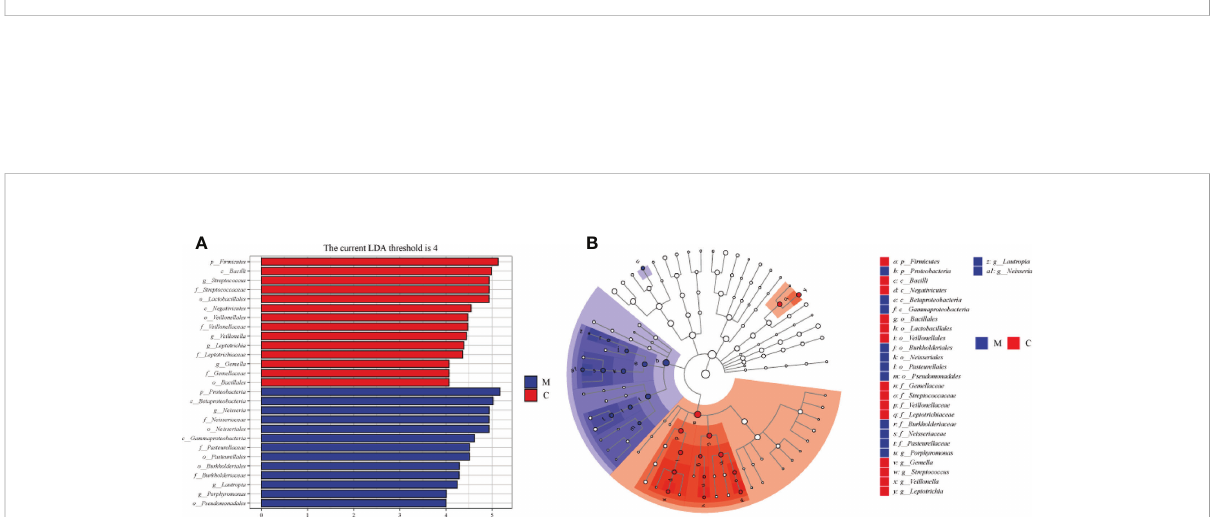
FIGURE 4 Differences in dental plaque microbiota composition between the methamphetamine using (M) and control (C) groups. (A) Cladograms generated using LEfSe showing taxonomic differences between groups M and C. Nodes in blue and red represent taxa that are less and more abundant in group M relative to those in group C. (B) Linear discriminant analysis (LDA) scores for bacterial taxa differing in abundance between groups M and C. Positive and negative LDA scores indicate taxa enriched in groups M and C, respectively. Only taxa with P < 0.01 (Wilcoxon rank-sum test) and LDA > 4.0 are shown.